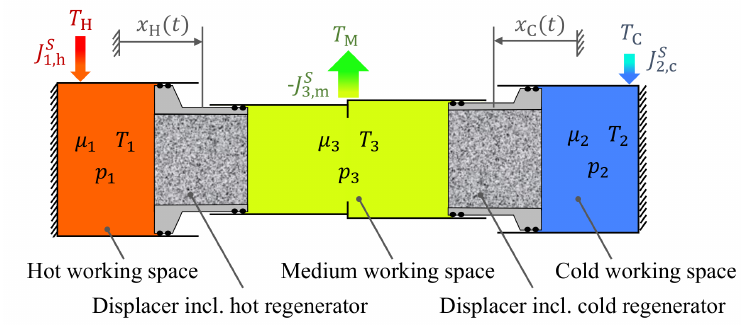
Figure 1. The longitudinal section of a Vuilleumier refrigerator (VR) displaying its general structure. Note the different cross-sectional areas on each of the two pistons’ sides. The piston positions are defined via the periodic functions x H ( t ) and x C ( t ) . The VR is, by finite heat conduction, connected to three heat baths with the constant temperatures T H > T M > T C . These heat exchanges are characterized by the entropy fluxes J S 1,h , J S 3,m , and J S 2,c . The VR consists of three working spaces, i = 1,2,3, that can exchange working gas through two regenerators. In those working spaces the temperatures T i , pressures p i , and chemical potentials µ i vary over time and are here assumed to be homogeneously